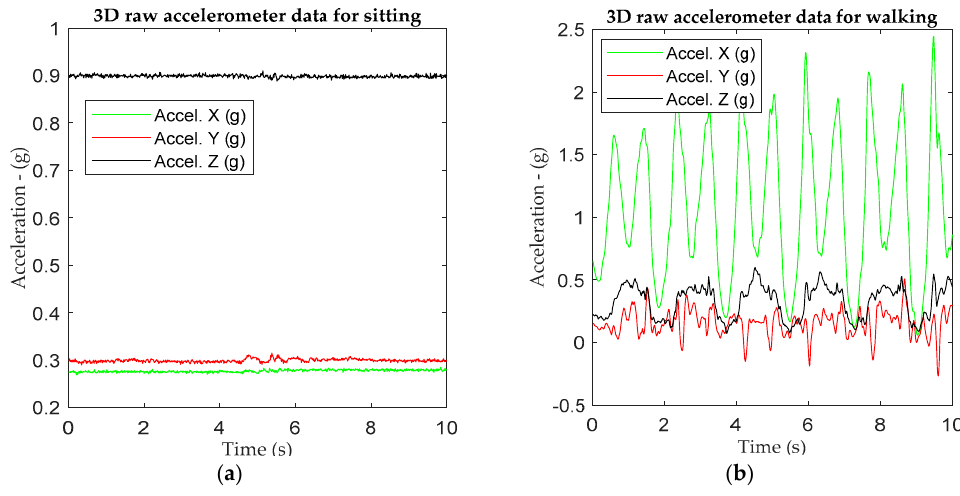
Figure 3. An example of 3D raw data for ( a ) sitting and ( b ) walking based on 1IMU sensor tied on the left-hand wrist.